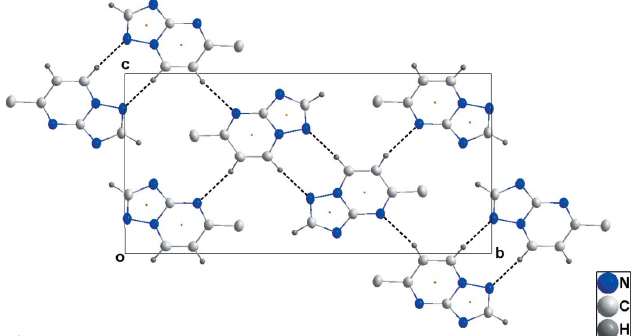
Figure 2 The packing viewed along the a -axis direction giving a plan view of the layers. C—H (cid:2)(cid:2)(cid:2) N hydrogen bonds are shown as black dashed lines and the orange dots mark the (cid:2) – (cid:2) stacking interactions.